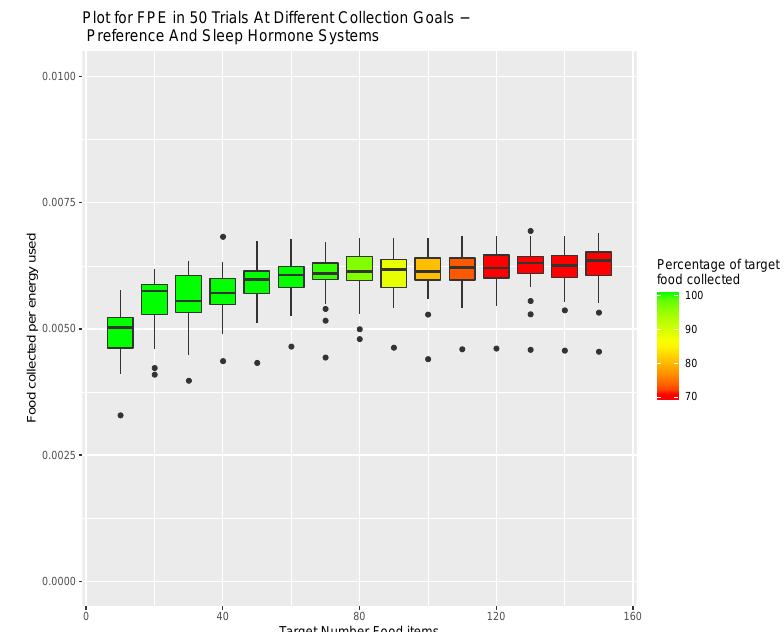
Figure 14. Hormone preference system, combined with the sleep hormone system tested in the environment containing two difference terrain types. Target number for items collected ranged from 10 to 150 items of food. Percentage of the items requested versus those collected by the end of the simulation is indicated by colour (Green 100% and Red <